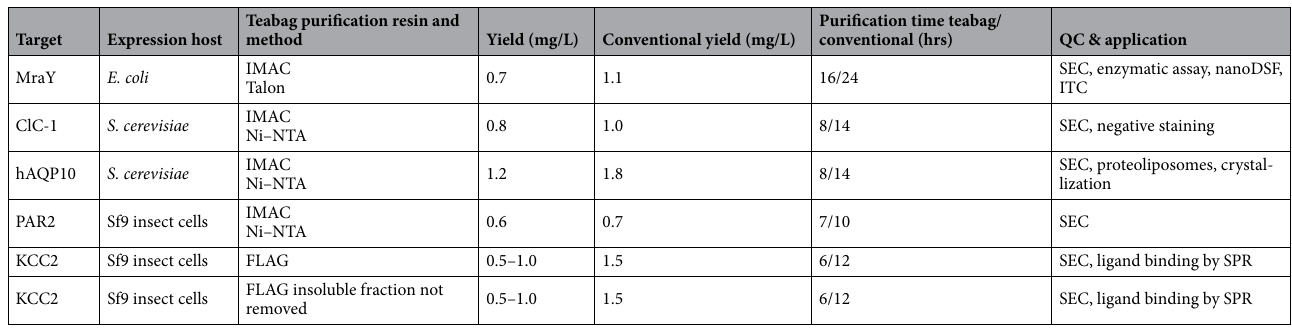
Table 1. Summary of purification results.